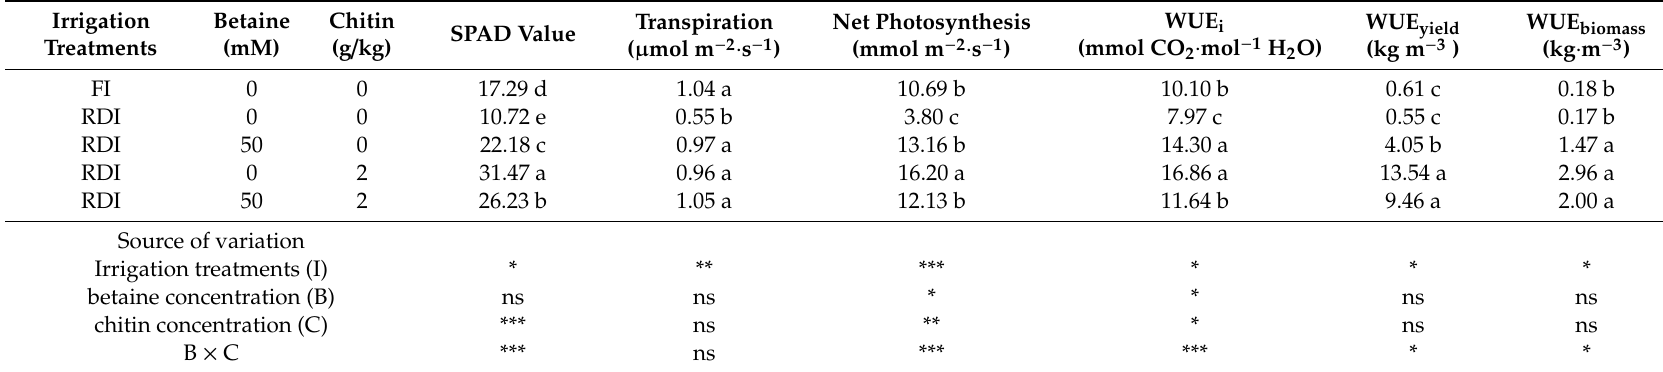
Table 6. E ff ects of di ff erent concentrations of betaine and chitin on the photosynthesis and water use e ffi ciency (WUE i , WUE yield , WUE biomass ) of maize under full irrigation (FI) and regulated deficit irrigation